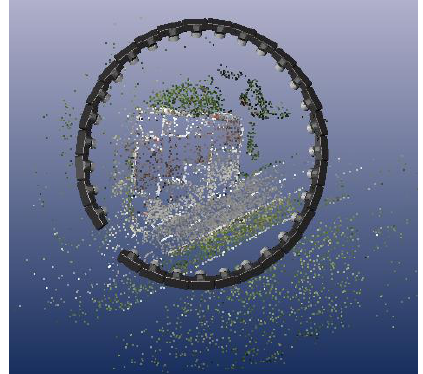
Figure 4. Camera Position and the sparse Point Cloud